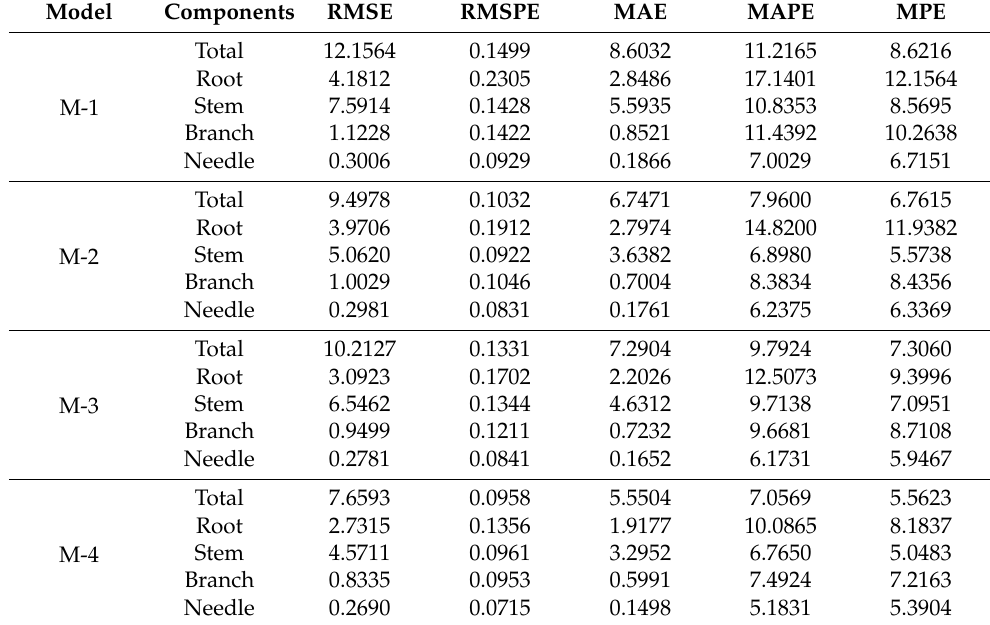
Table 4. The validation result of the larch ( Larix spp.) plantation’s stand-level biomass